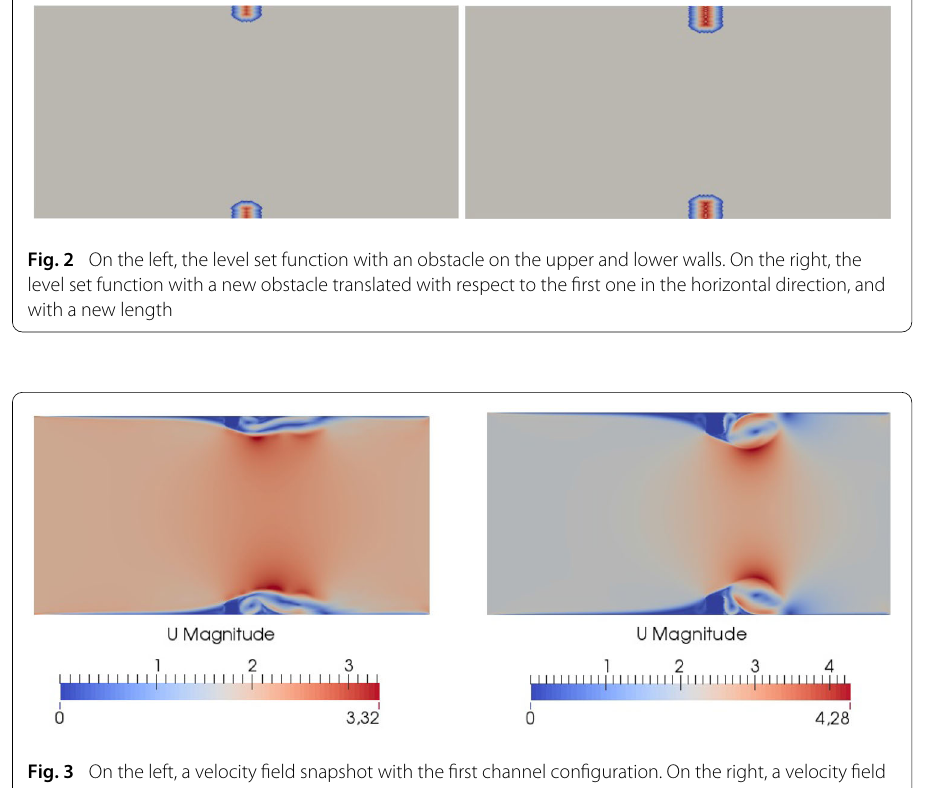
Fig. 3 On the left, a velocity field snapshot with the first channel configuration. On the right, a velocity field snapshot with the second channel configuration, see